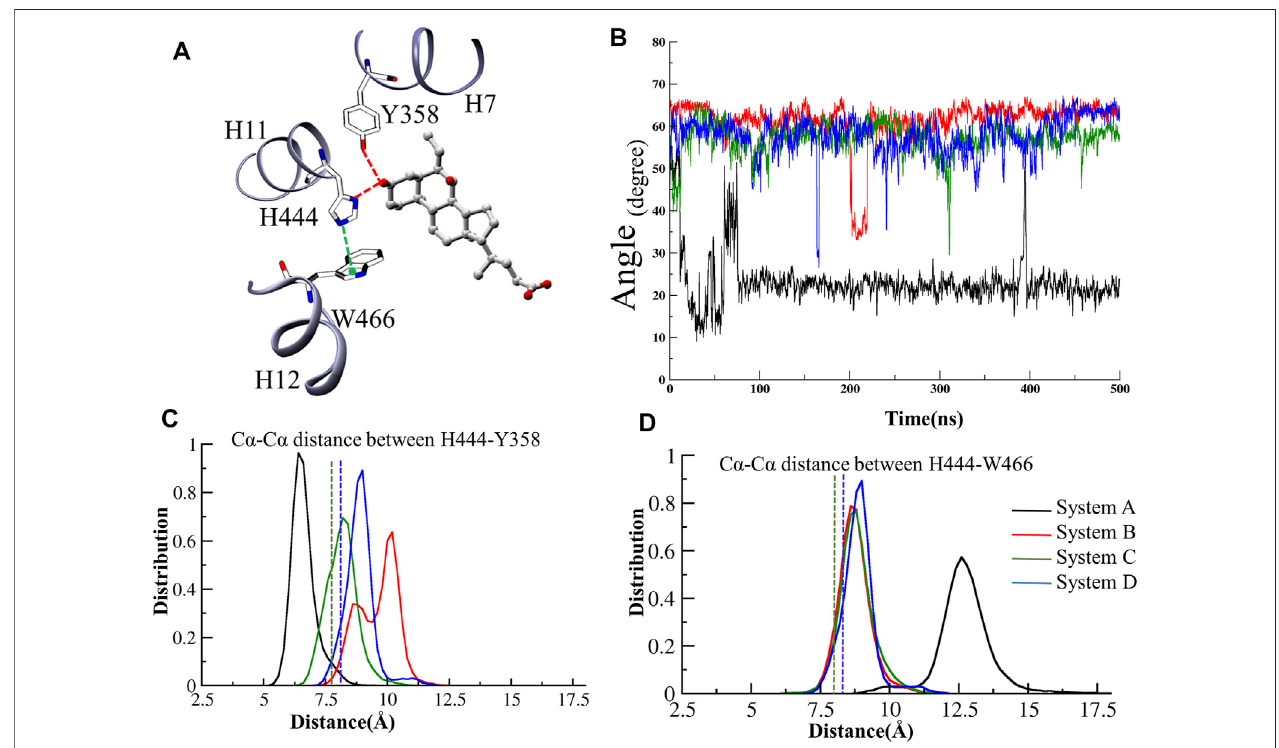
FIGURE 7 | The activation trigger zone analysis. (A) The view of the “ activation trigger ” zone in the FXR structure involves the interaction between a tyrosine- histidine-tryptophan (Y358/H444/W466) triad and the ring A of the steroid bile acid backbone. The HB between the Y358 and H444 with the ‘ OCA ’ is shown in red dotted line. The cation-pi interaction between the NE@H444 (H10-11) atom with the center of indole ring of residue W466 (H12) is shown in green dotted line. (B) The time series of angle between the atoms of CD1 ＠ W466-CE1 ＠ H444-CH2 ＠ W466 is depicted. The distribution plot for the distance between C α atoms of (C) residues of H444 and W466 (D) residues Y358 and H444, throughout MD simulations. The green and blue dotted lines represent the C α distances in the crystal structures of System C and D,